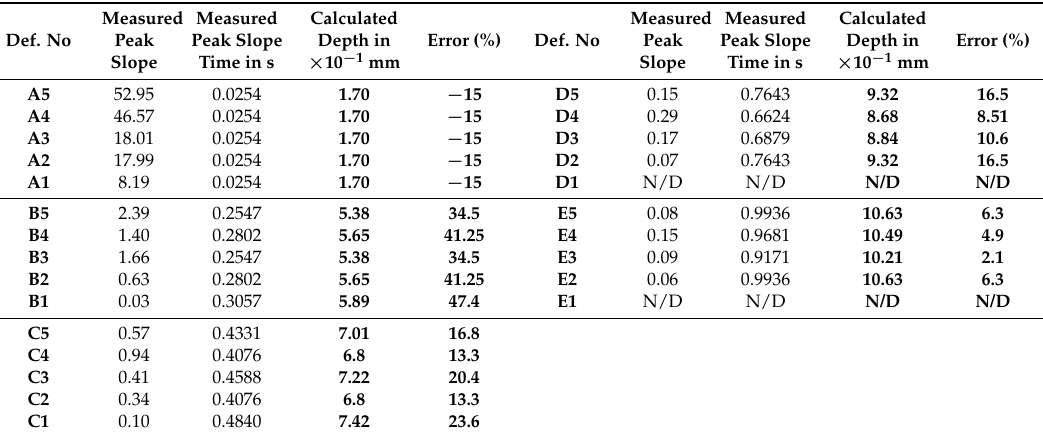
Table A1. Depth estimation using peak slope time.